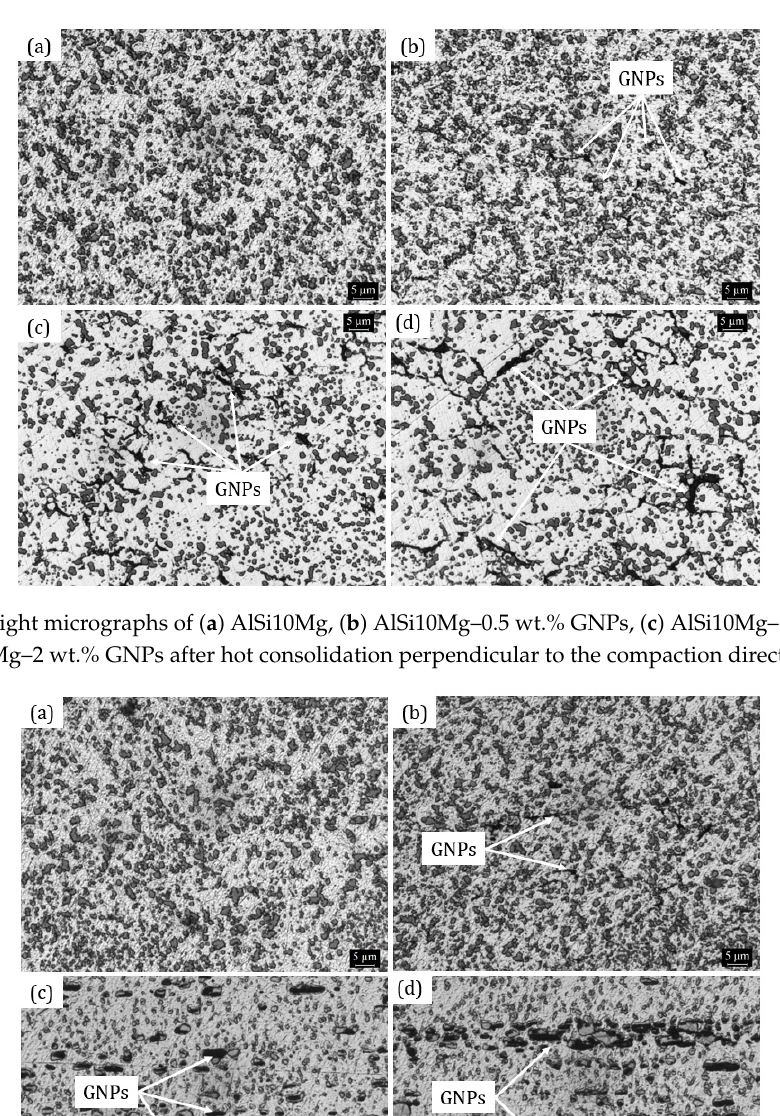
Figure 3. Light micrographs of ( a ) AlSi10Mg, ( b ) AlSi10Mg–0.5 wt.% GNPs, ( c ) AlSi10Mg–1 wt.% and ( d ) AlSi10Mg–2 wt.% GNPs after hot consolidation perpendicular to the compaction direction. Figure 4a-d is the Optical micrographs of AlSi10Mg– x GNPs ( x = 0, 0.5, 1.0, 2.0 wt.%). These